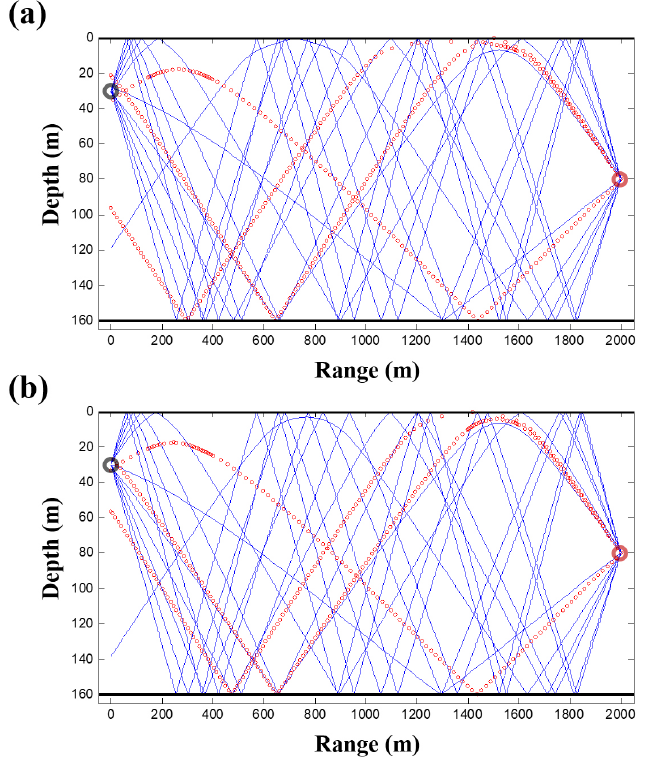
Figure 10. Backpropagated ray trajectories of arrivals less than 30 ◦ . ( a ) reference and ( b ) estimated sound speed profile